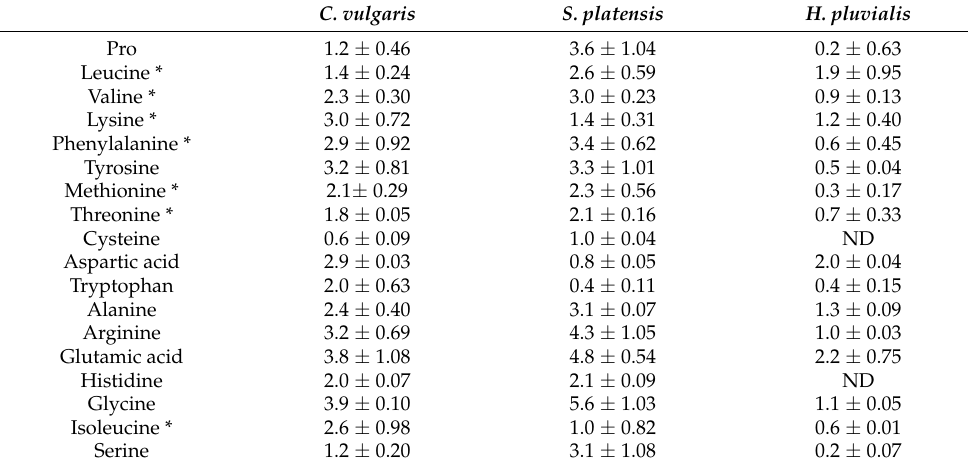
Table 2. Amino acids compositions and contents (g/100 g dry biomass) of cultivated